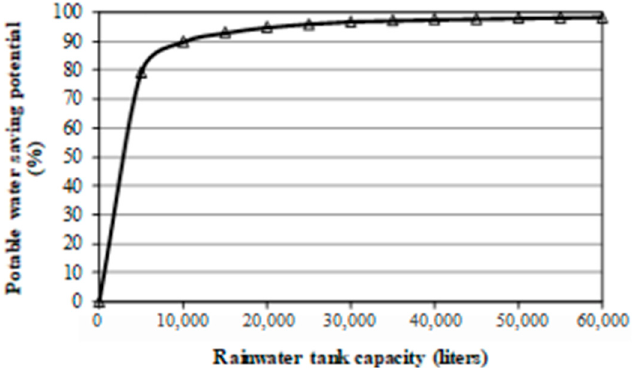
Figure 10. Potential for potable water savings as a function of the rainwater tank capacity.